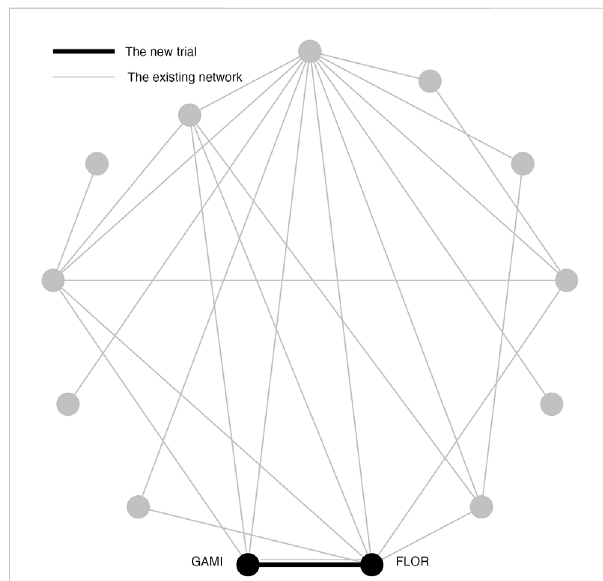
FIGURE 2 An existing network of interventions for the treatments of Bovine Respiratory Disease (BRD) in feedlot cattle with a new study between GAMI(C) and FLOR(D) where C and D had direct comparison in the existing